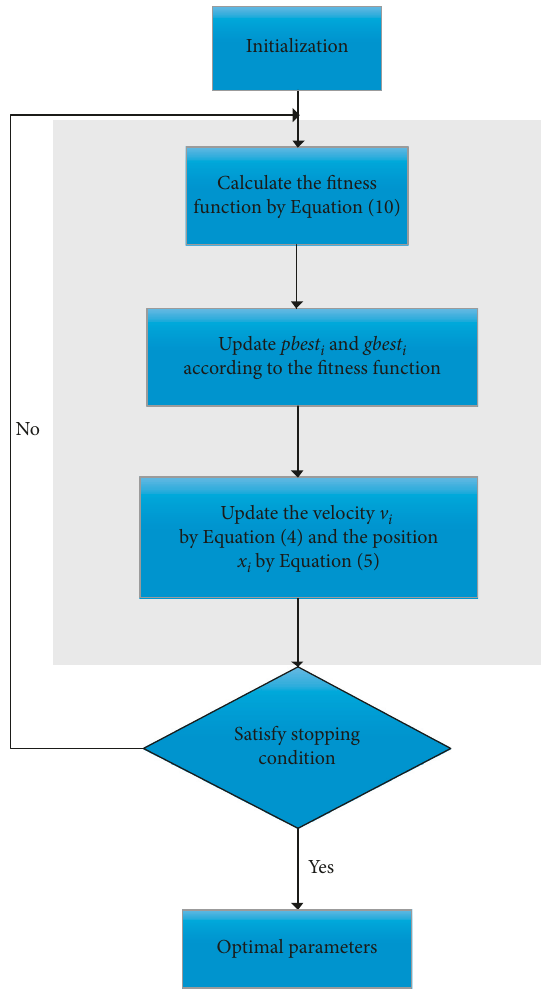
Figure 1: Flowchart of PSVM